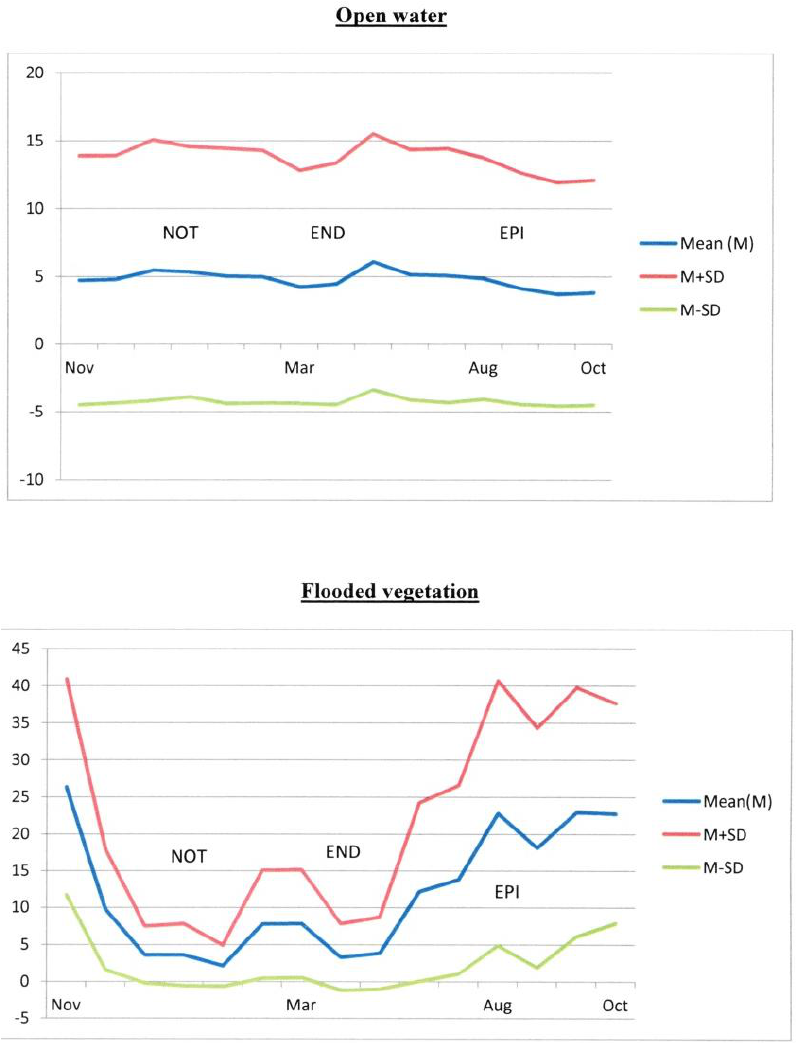
Figure 3. Variations in mean percentages of open water and flooded vegetation areas in buffers of 2-km radius around stables in the study zone, during the study period (SD = Standard